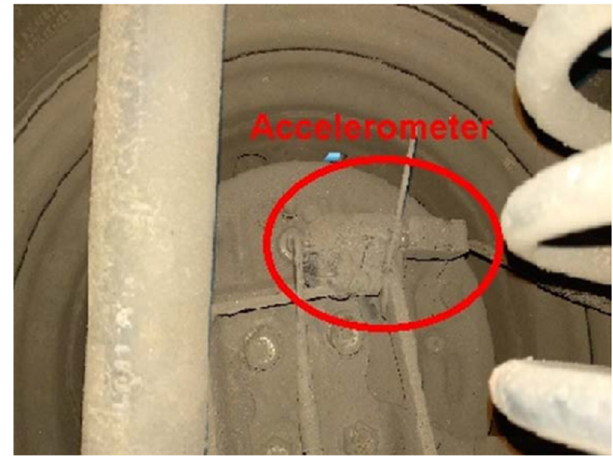
Figure 3. MEMS Accelerometer attached to the rear axle of the test vehicle.